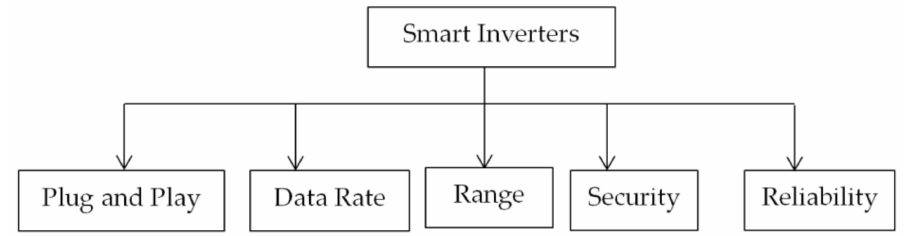
Figure 3. Features of a smart